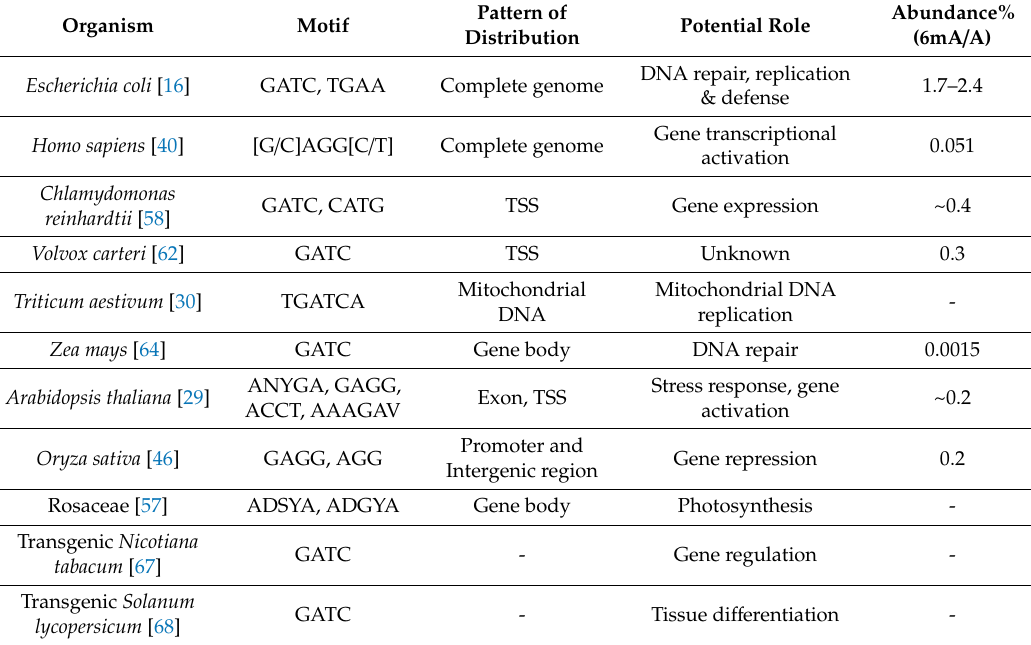
Table 1. The distinctive attributes of 6mA in plants compared with E.coli and human.